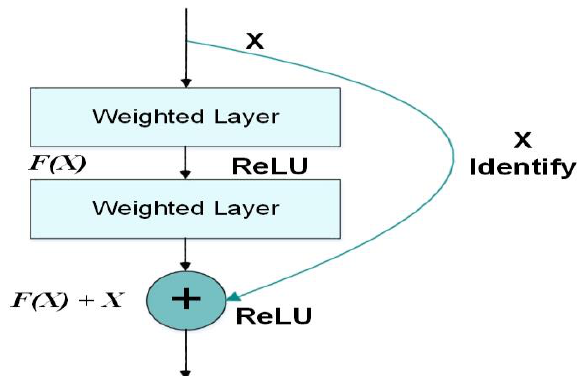
Figure 10. Building block for the residual learning.